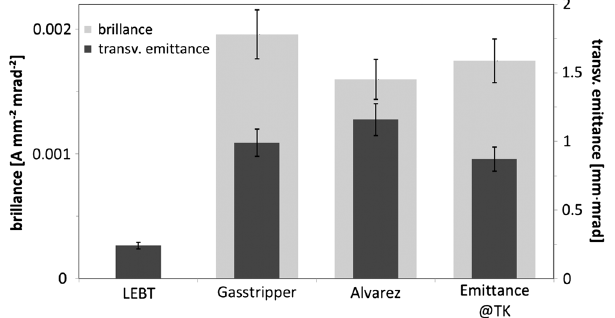
FIG. 11. Measured emittance growth and beam brilliance along the UNILAC [5].